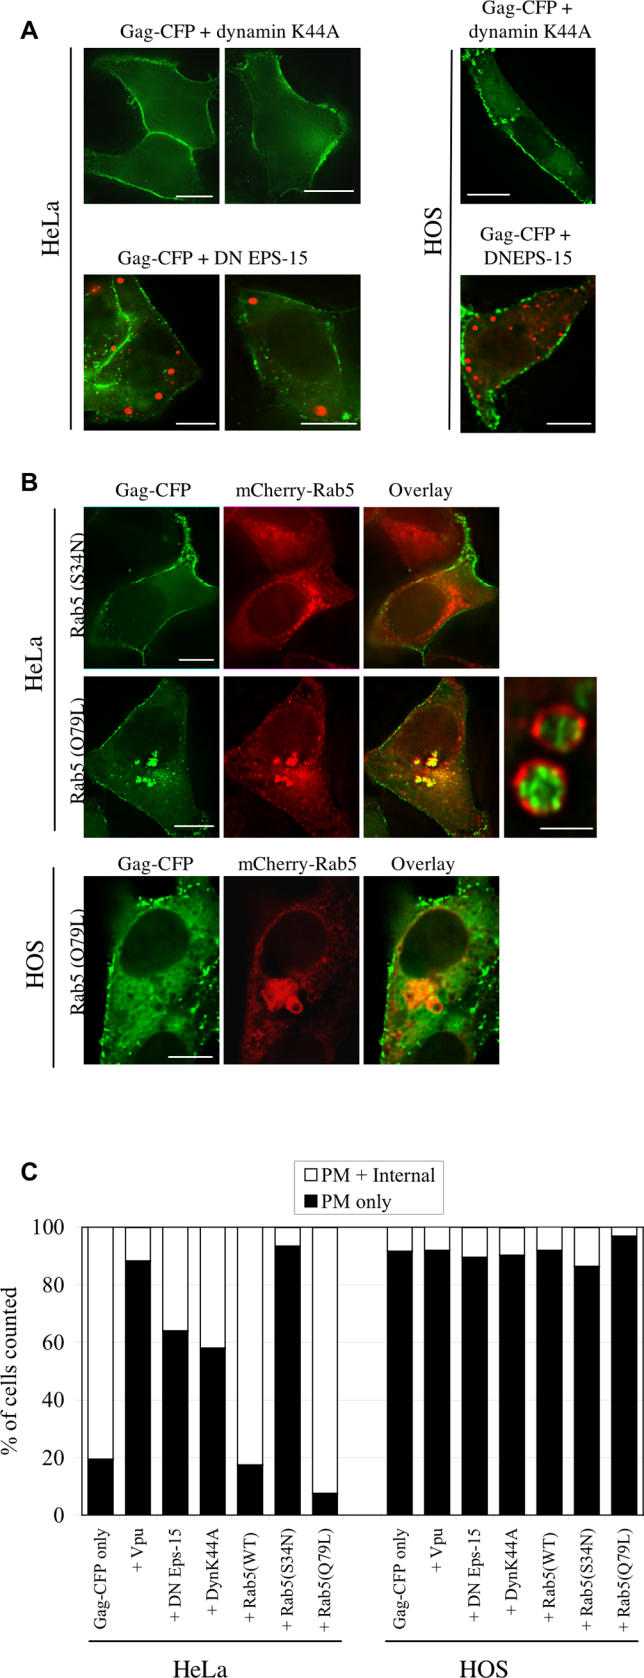
DN Mutants of Cellular Proteins that Mediate PM-to-Early-Endosome Transport Affect Gag-CFP Localization in HeLa, but Not HOS Cells(A) HeLa cells (left panels) or HOS cells (right panels) were transfected with plasmids expressing HIV-1 Gag-CFP (green) and either dynamin K44A (no color) or dnEPS-15-YFP (red). Cells were fixed at 18 h post-transfection and analyzed using deconvolution microscopy.(B) HeLa cells (upper and center panels) expressing HIV-1 Gag-CFP (green), and either DN (S34N) or constitutively active (Q79L) mutants of CherryFP-Rab5a (red), were fixed and images acquired 18 h post-transfection. The far-right-center panel shows an example of how localization of HIV-1 Gag-CFP in swollen CherryRab5aQ79L early endosomes could be resolved as apparently particulate fluorescence within a vesicle lumen. (B, lower panels) shows a similar analysis HIV-1 Gag-CFP localization (green) in the presence of CherryFP-Rab5a(Q79L) in HOS cells. White bars in the micrographs indicate a distance of 10 μm, except in the far-right-center panel of (B) where a distance of 1 μm is indicated.(C) The numbers of HIV-1 Gag-CFP–expressing cells in ten fields exhibiting PM Gag-CFP accumulation only (black bars) or additional intracellular accumulations (white bars) in the presence of the indicated co-expressed cellular proteins was counted, as in Figure 2C, and is plotted as a percentage of the total number of cells with Gag-CFP accumulations.